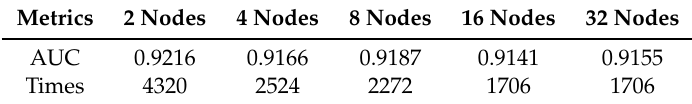
Table 3. AUCs and Consumed Times(s) obtained by HDPA with different numbers of